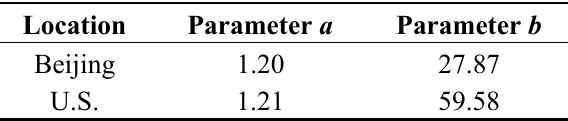
Table 4. Sensitivity analysis